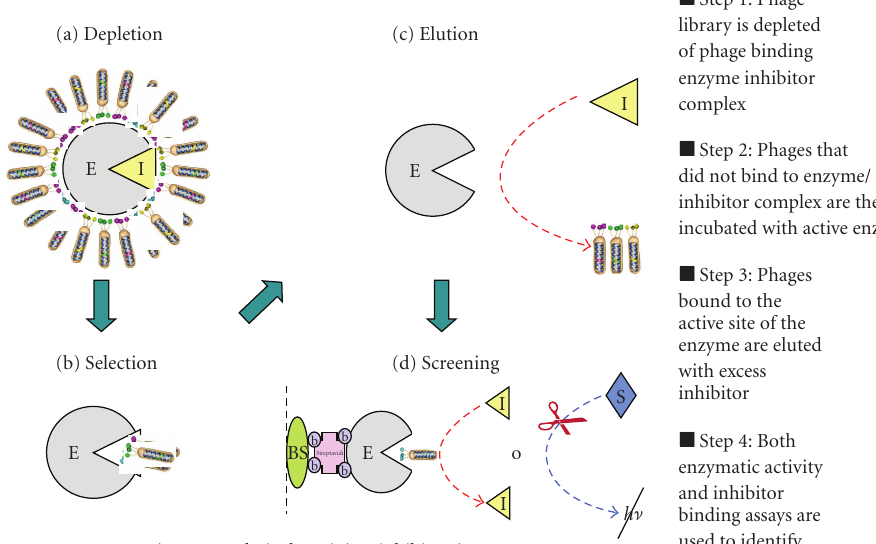
Figure 1: MMP inhibitor selection